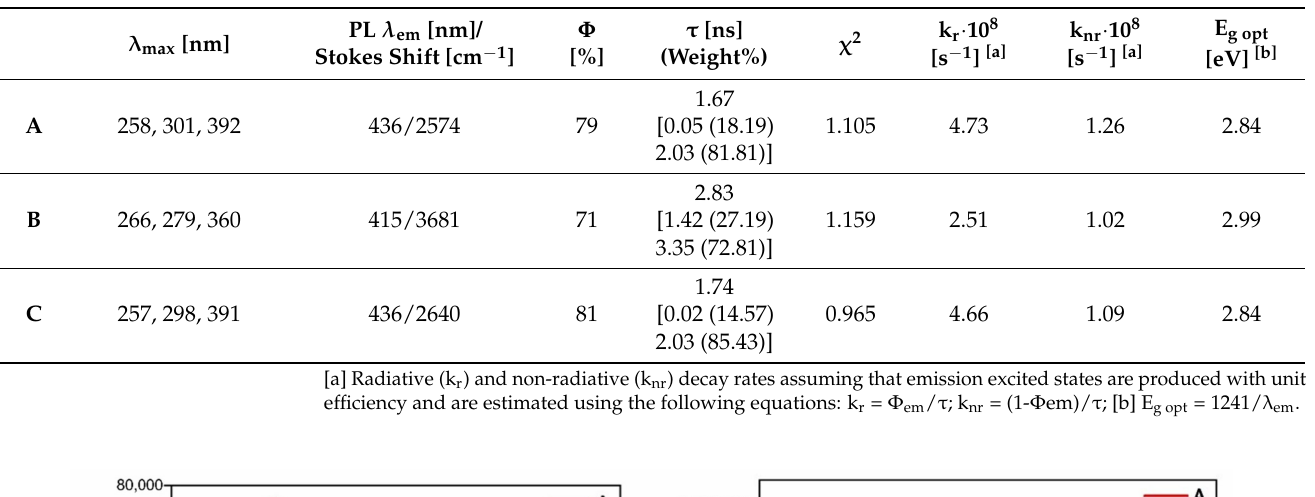
Figure 5. Absorption ( a ) and emission ( b ) spectra recorded in the chloroform solution ( c = 10 − 5 mol/L) for molecules A – C . Table 4. Photophysical and optical data recorded in the chloroform solution ( c = 10 − 5 mol/L) for molecules A – C .